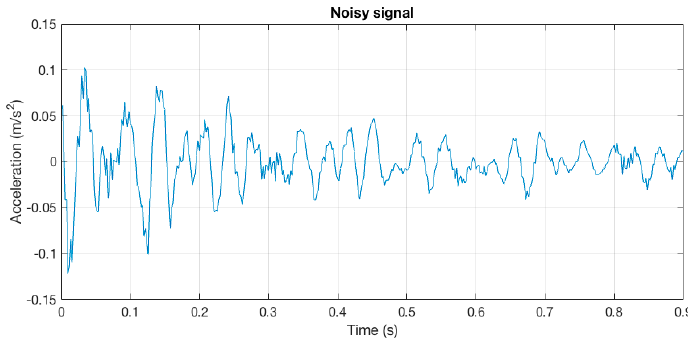
Figure 10. Filtered signal using a 9th-order Butterworth filter.